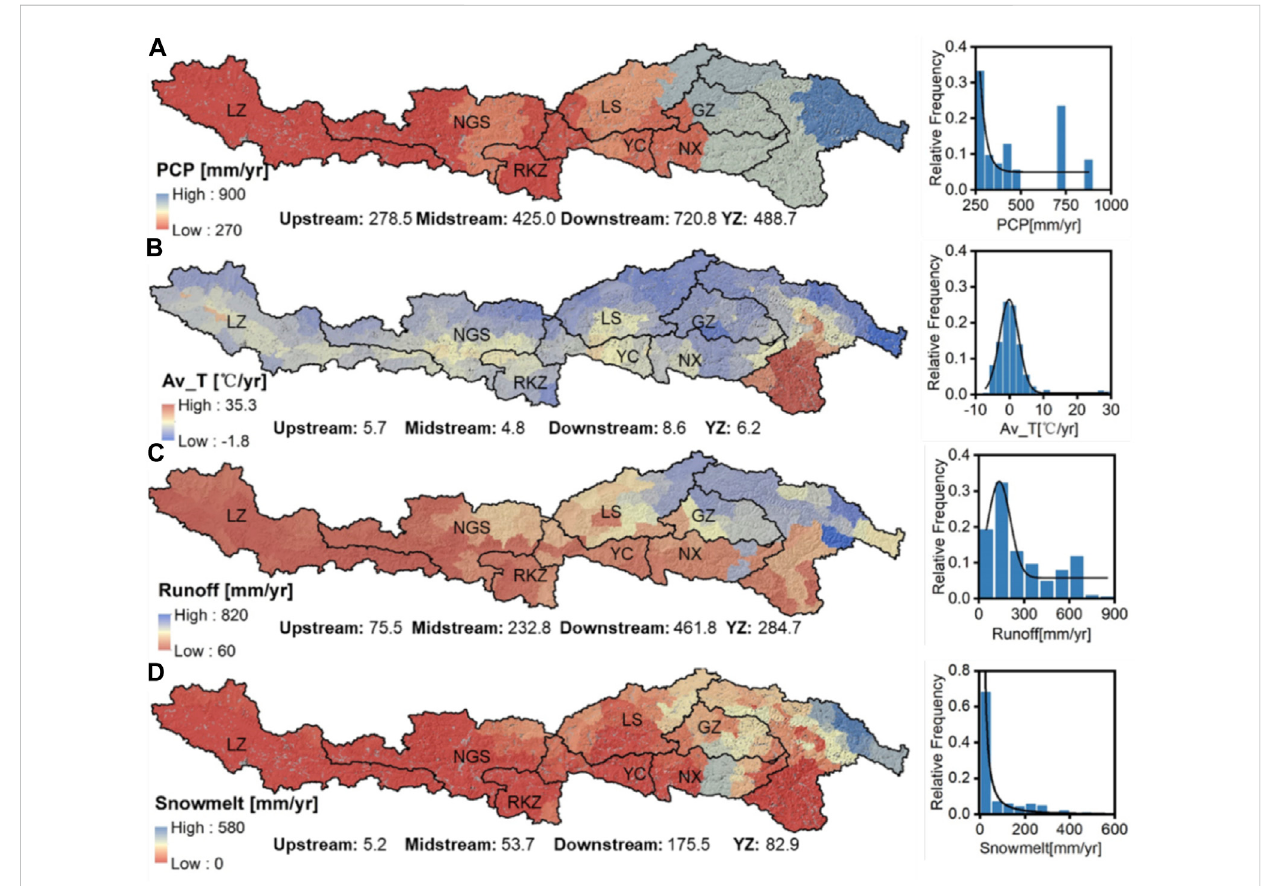
FIGURE 3 Spatial distribution of (A) precipitation (PCP), (B) average temperature (Av_T), (C) runoff, and (D) snowmelt in the historical period (1980 –